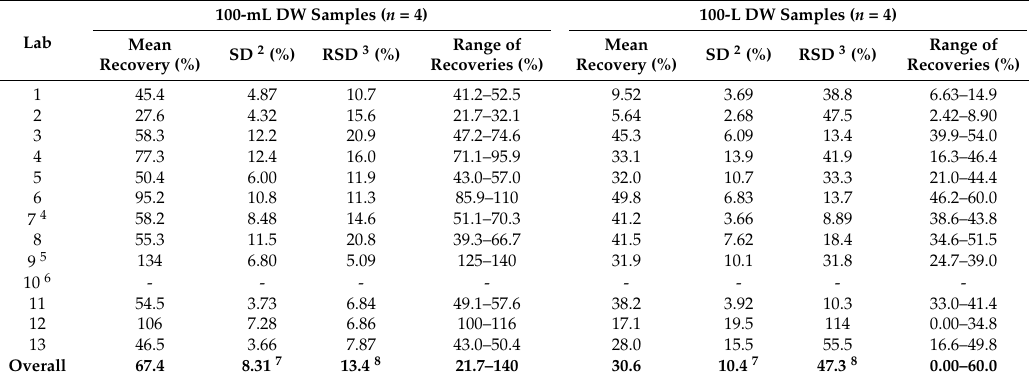
Table 3. Summary of MS2 recoveries for spiked, 100-mL and 100-L DW samples analyzed using EPA Method 1602 and EasyPhage 1